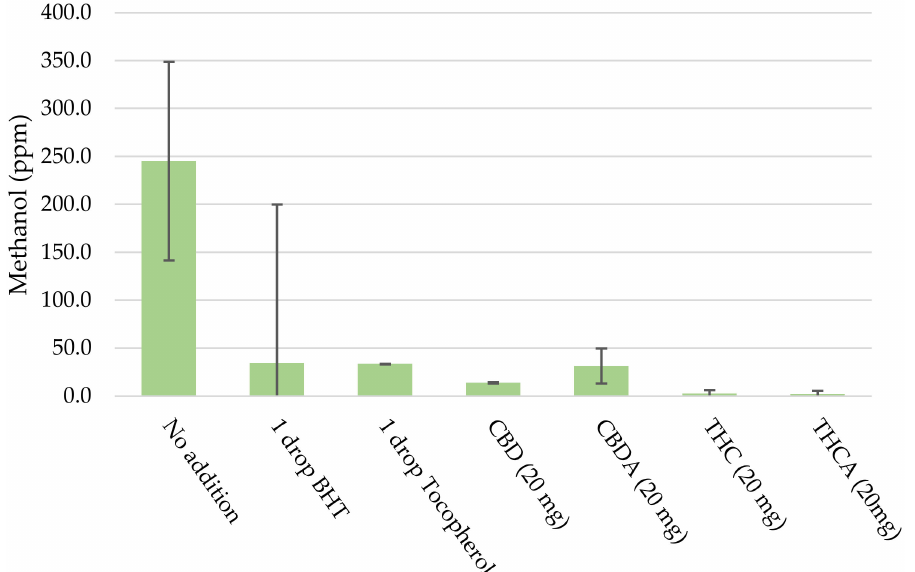
Figure 4. Detection of methanol (PPM) in samples with added antioxidants (error bars show the 95% confidence